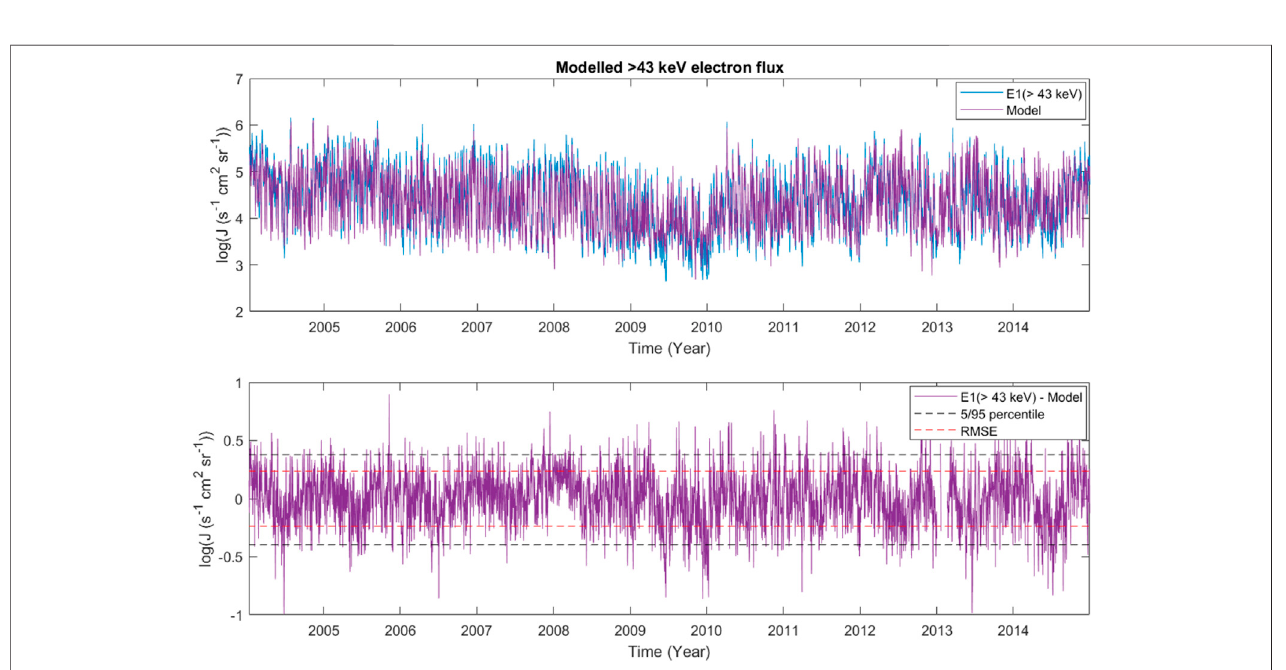
FIGURE 6 | The upper panel shows the observed (blue) and modelled (purple) daily resolved fl uxes > 43 keV in the period from 2004 to 2014. The lower panel shows the difference between the observed and modelled fl uxes.